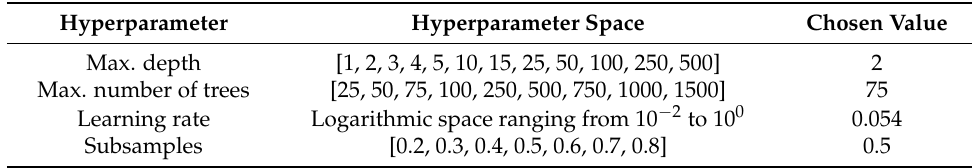
Table 3. Hyperparameters of the XGB